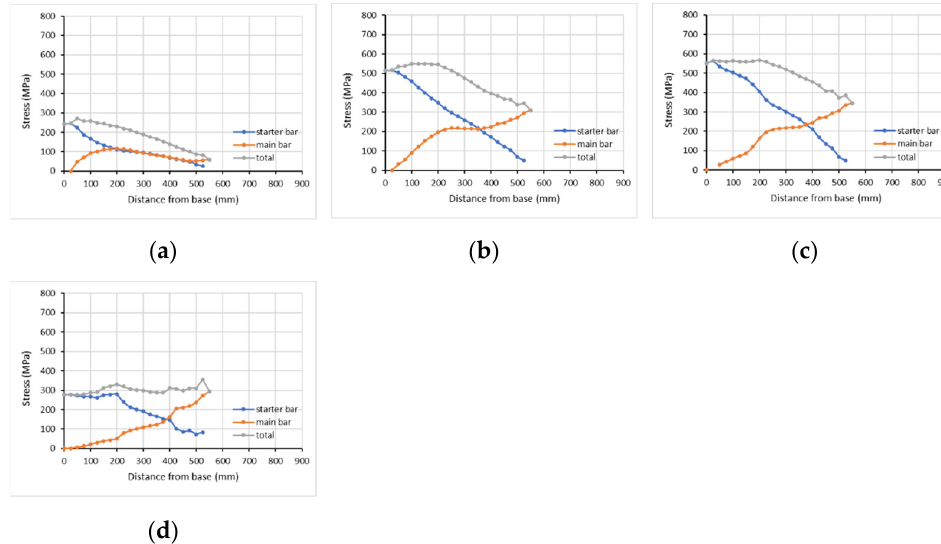
Figure 14. Developed stress along lap splice length at a displacement of ( a ) 3.16 mm, ( b ) 8.22 mm ( δ y ), ( c ) 16.64 mm ( δ Pmax ), and ( d ) 27.20 mm ( δ u ), for column R-0L3.